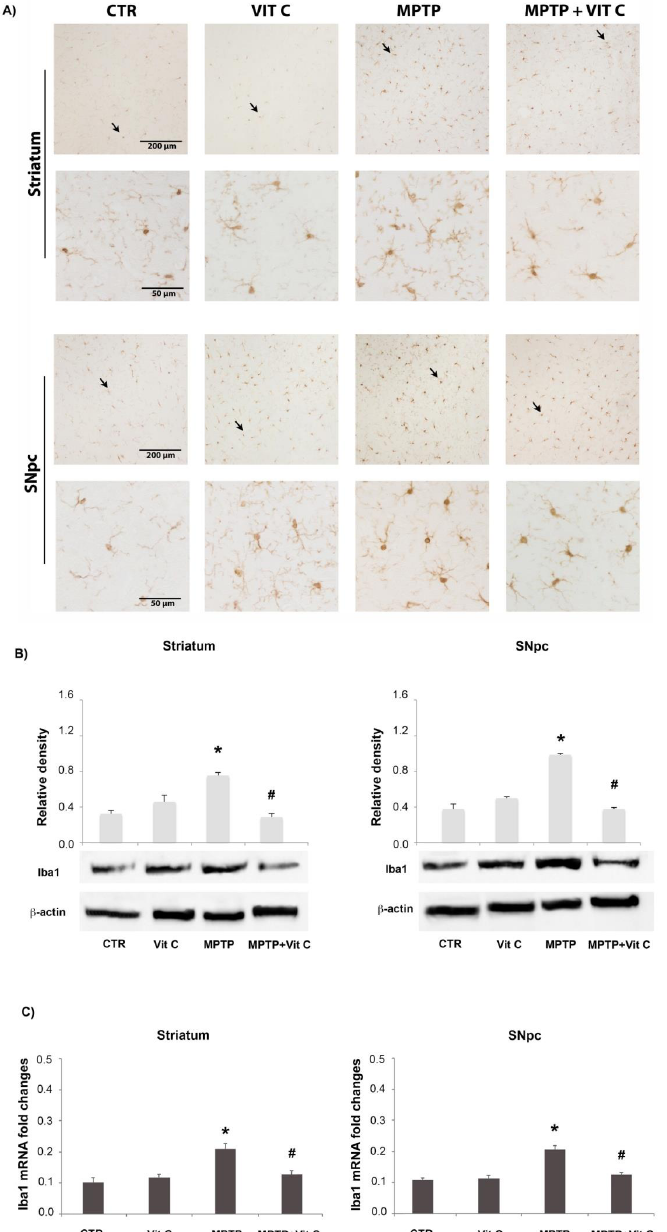
Figure 3. Iba1 analysis. ( A ) Iba1 immunoreactive microglial cells in striatum (upper) and SNpc (lower) of controls (CTR), mice treated with Vitamin C (VIT C), MPTP, MPTP, and Vitamin C (MPTP+ VIT C). Scale bar: (striatum) upper 200 µ m (obj. 10 × ), lower 50 µ m (obj. 40 × ); (SNpc)upper 200 µ m (obj. 10 × ), lower 50 µ m (obj. 40 × ). In low magnification images, arrows point to Iba1 immunoreactive cells shown in high magnification ones. ( B ) Western blotting detection and densit- ometric analysis of Iba1 expression levels in controls (CTR), mice treated with Vitamin C (VIT C), MPTP, MPTP, and Vitamin C (MPTP+ VIT C) in striatum ( left ) and SNpc ( right ). Protein expression analysis values are expressed as arbitrary units after normalization against β -actin, used as a loading control ( n = 5 in each group, 5 replicates). ( C ) Real-time PCR analysis of Iba1 mRNA expression levels in controls (CTR), mice treated with Vitamin C (VIT C), MPTP, MPTP, and Vitamin C (MPTP+ VIT C) in striatum ( left ) and SNpc ( right ). Results are presented as mRNA fold changes relative to GAPDH, used as resident control. Data are presented as mean ± SD (* p < 0.05 vs. CTR; # p < 0.05 vs. MPTP). Supplementary Figure S3 shows the full western blots of Figure